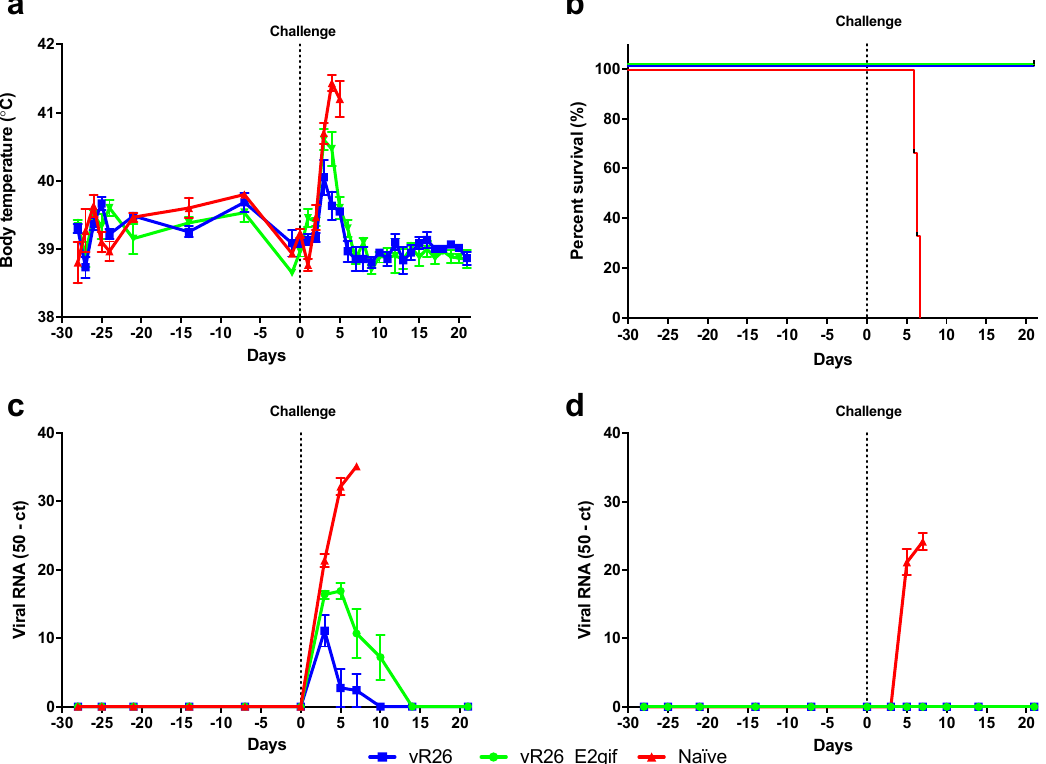
Figure 1. Naïve pigs ( n = 3) or pigs vaccinated with vR26 ( n = 6), or vR26_E2gif ( n = 6) were challenged with the highly virulent classical swine fever virus (CSFV) strain “Koslov”. The graphs show the (mean ± SEM values where appropriate) for: ( a ) body temperature, ( b ) pig survival (%), ( c ) viral RNA in blood, measured by RT-qPCR, shown as 50-ct, and ( d ) viral RNA in nasal swabs measured by RT- qPCR.